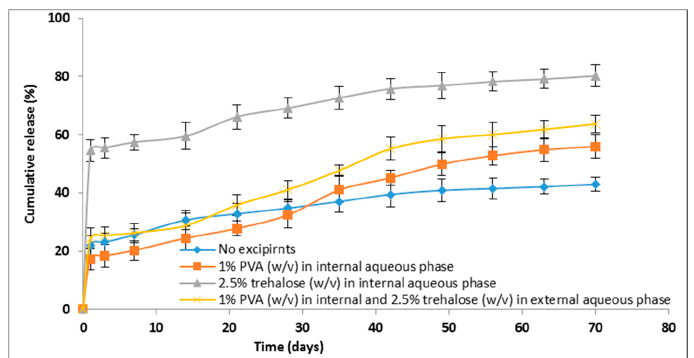
Figure 5. In vitro release profiles of lysozyme from double-walled microspheres prepared together with excipients and without excipients in the internal and external aqueous phase during preparation.